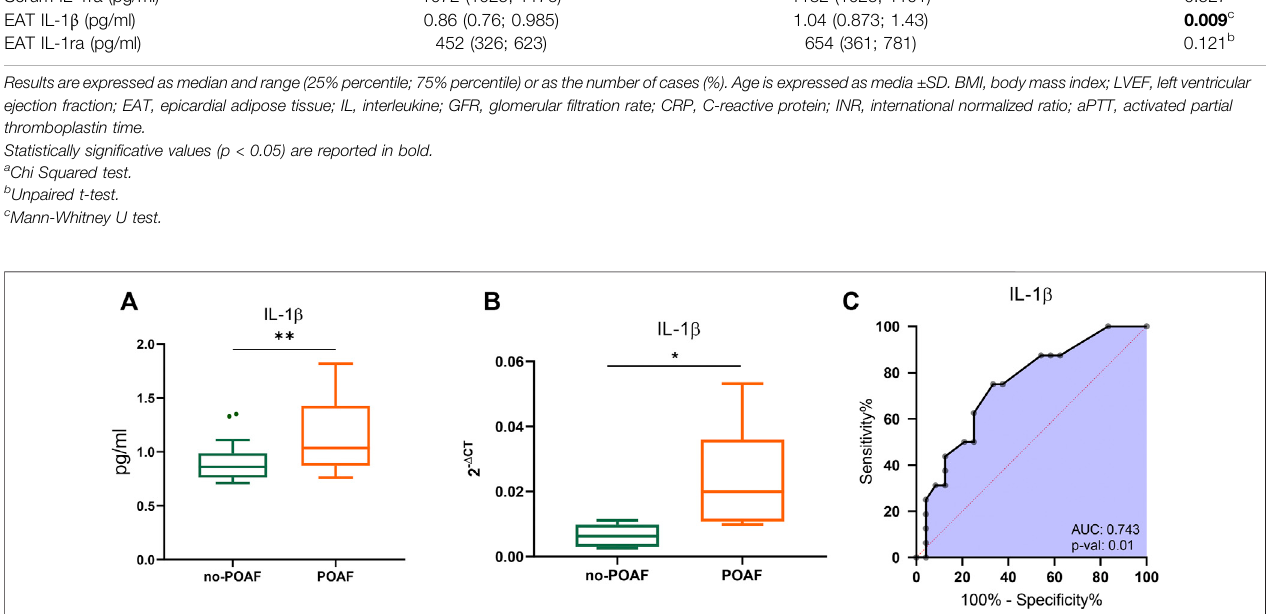
Frontiers in Cell and Developmental Biology |